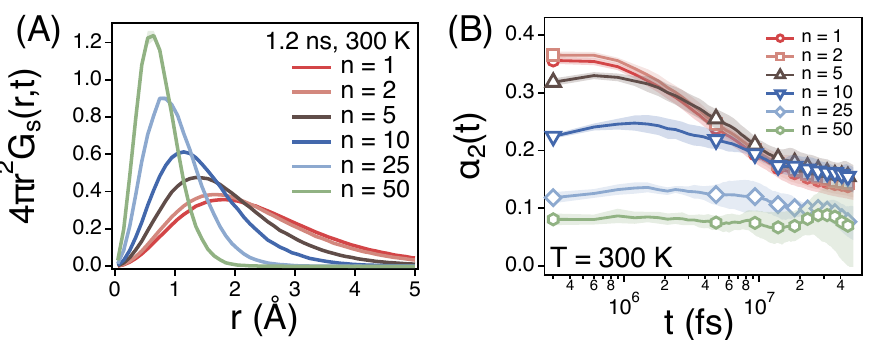
Figure 5. Simulation results for ( A ) the self-part of van Hove correlation functions ( G s ( r , t = 1.2 ns)) and ( B ) the non-Gaussian parameters ( α 2 ( t ) ) of the centers of mass of strands of size n at T = 300 K. Each shade represents a statistical error.